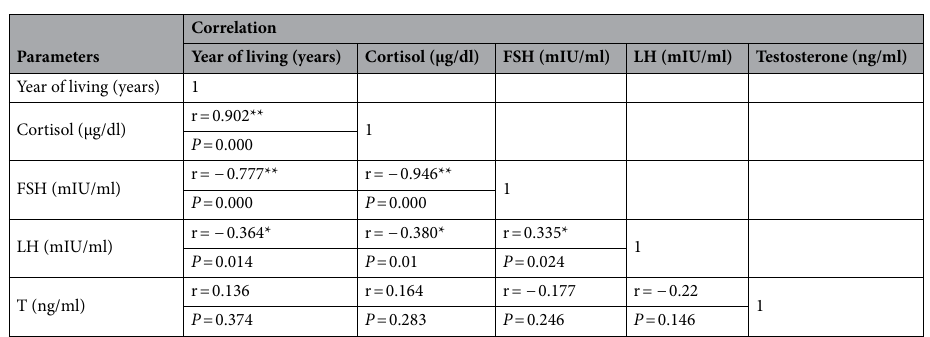
Table 5. Summary of the Pearson’s correlations between plasma LH, FSH, testosterone, and cortisol with number of living years at brick kiln sites. Pearson’s correlation and significant relation; Pearson’s correlation is shown with r whenever significant by P -value. ** Correlation is significant at the 0.01 level (2-tailed).